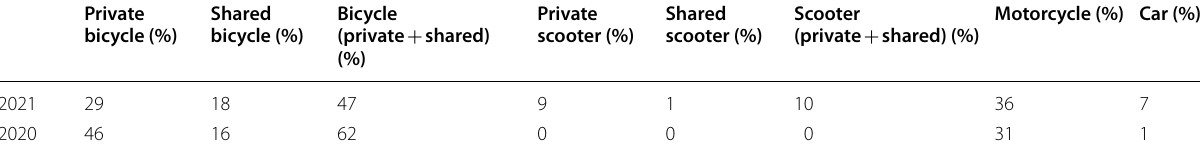
Table 6 Transportation modes used by the couriers in 2020 and 2021. Source : Author’s surveys Private bicycle